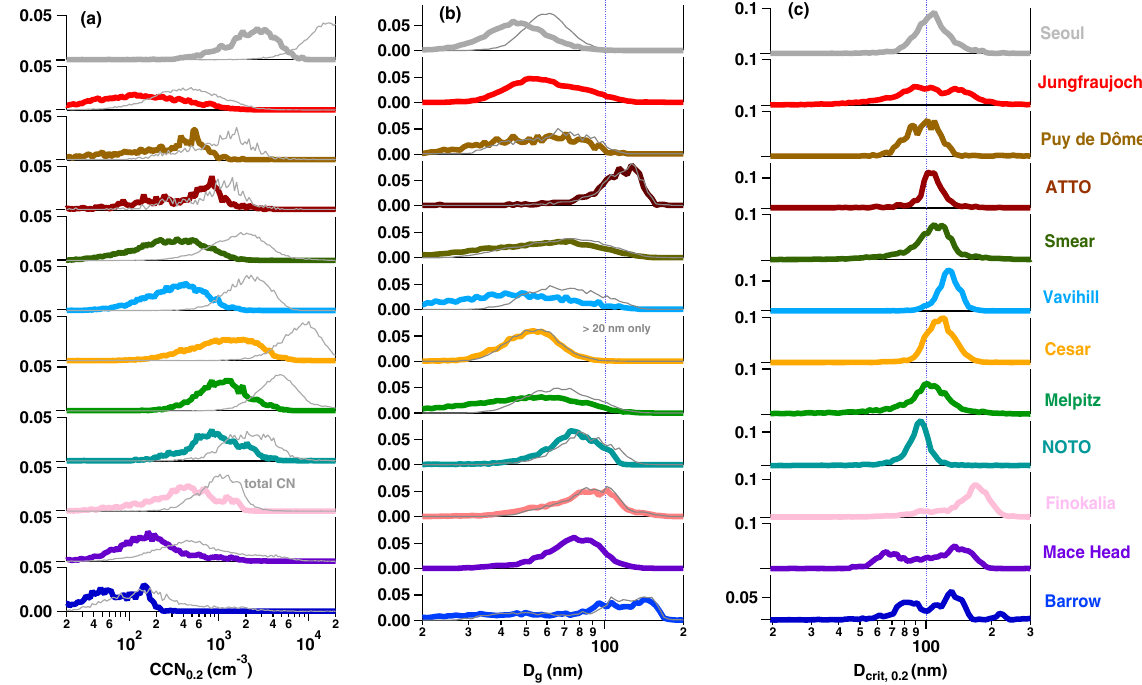
Figure 3. (a) Normalised frequency distributions of CCN number concentration at SS = 0.2% and total particle number in light grey, (b) geometric mean diameter D g , and (c) critical diameter D crit at SS = 0.2%. The grey lines in (b) are based on size distributions starting at 20nm. The critical diameter is derived from the total CCN concentration (SS = 0.2%) and the integrated particle number concentration starting from the largest diameter (see Sect. 2.2.2 for details). Note that seasons are not represented by an equal number of data points at each station which can lead to small biases in the frequency distributions. In (a) and (c) all axes start at